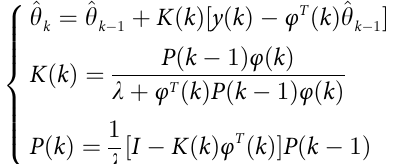
Fig 4. Typical arrangement of the array table. (a) Dual array system; (b) Y-moving multi-array system; (c) x—moving multi—array system; (d) Dual horizontal motion multi array system.